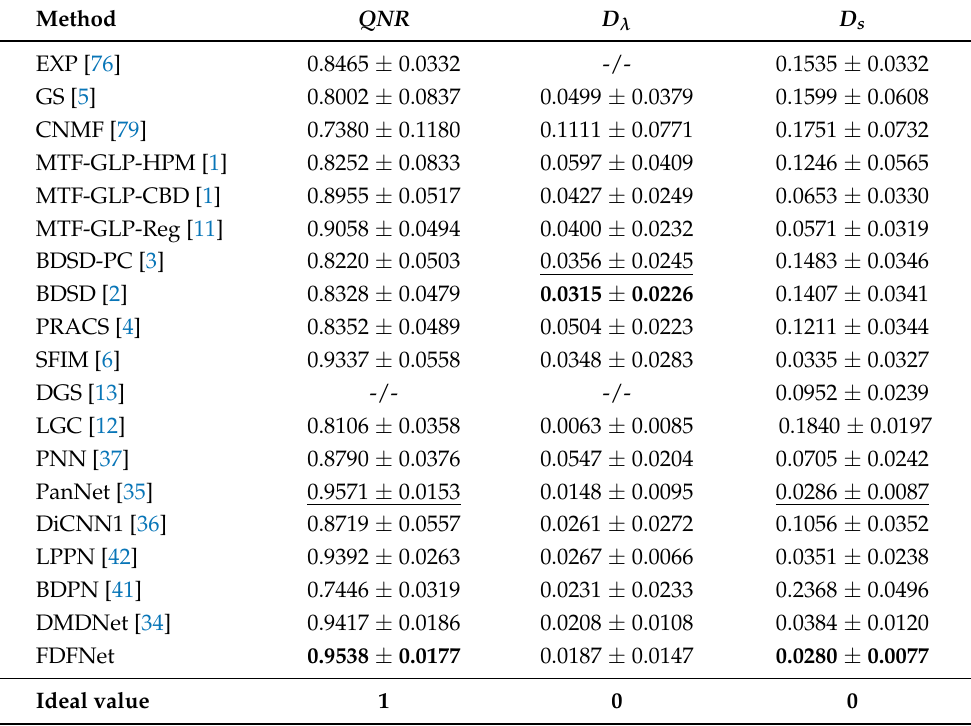
Table 7. The average quantification compared to the relative standard deviation (std) of 36 full- resolution GF2 samples. The best performance is shown in bold and second place is